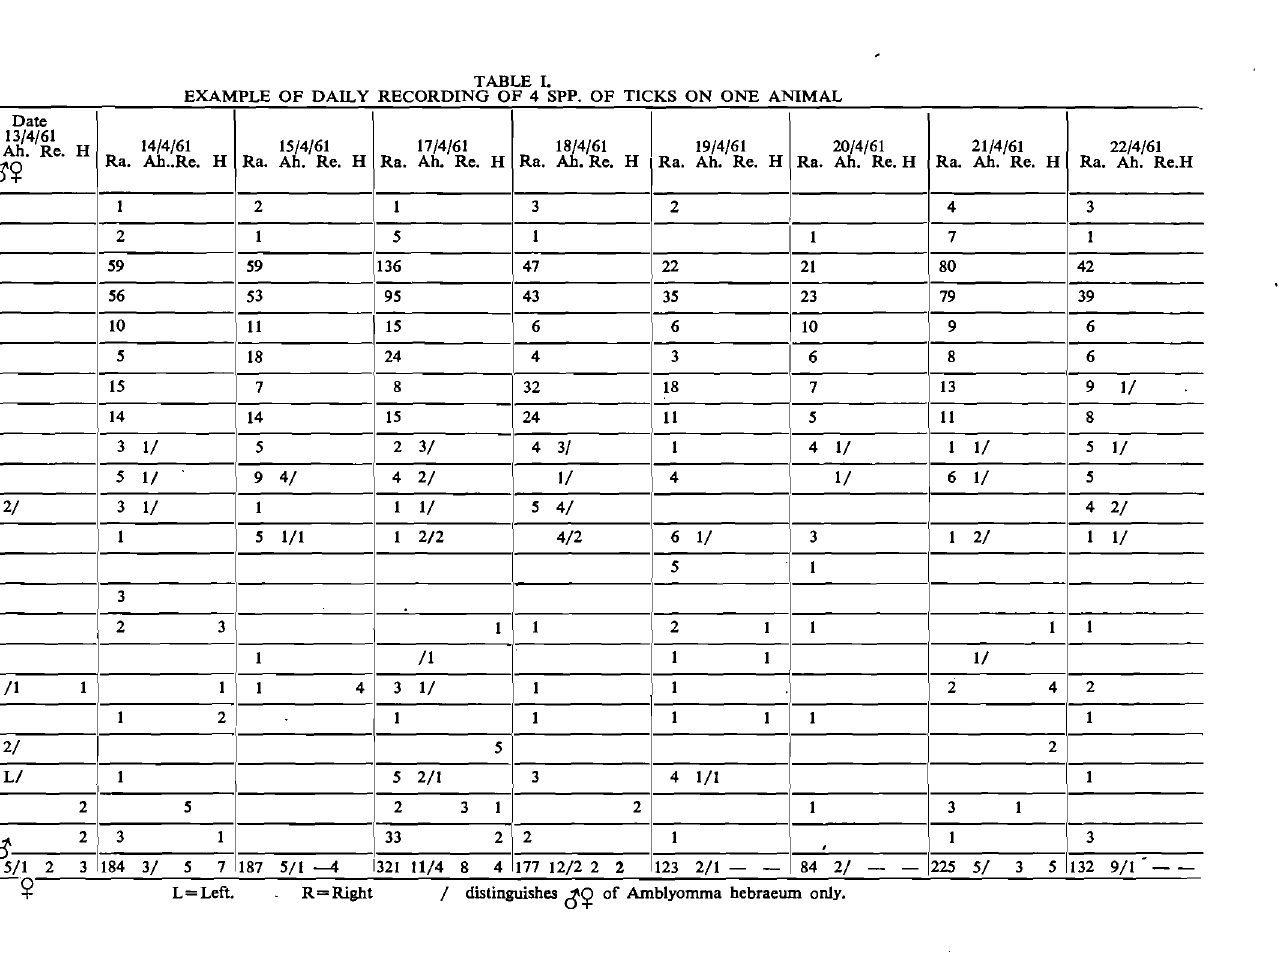
L=Left. R=Right / distinguishes b'~ of Amblyomma hebraeum